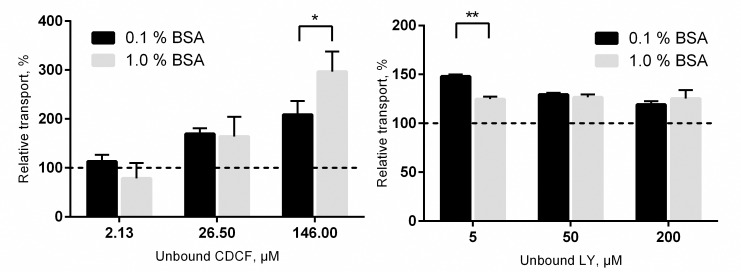
The comparison of 0.1% and 1.0% BSA effect on uptake kinetics.(Left panel) CDCF uptake into MRP2 vesicles, (right panel) Lucifer Yellow (LY) uptake into BCRP vesicles. Each bar represents the mean (± SD) of 2–3 separate experiments. The uptake rate of the control (0% BSA) was set to 100% and uptake rates in the presence of 0.1% and 1.0% BSA were normalized to control. * p < 0.05 and ** p < 0.01 compared to the uptake in the absence of BSA.